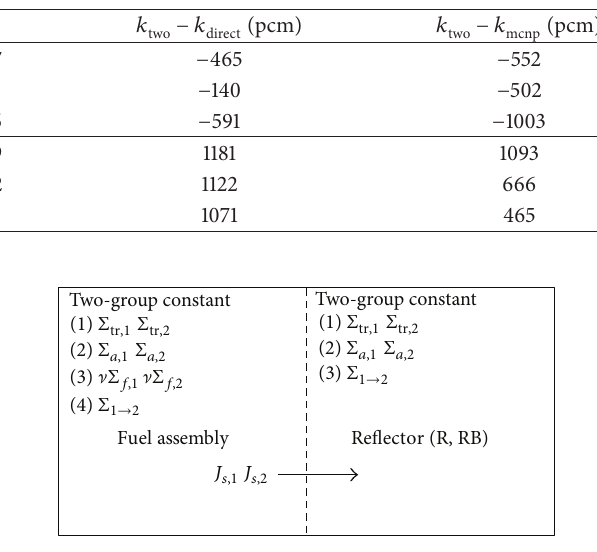
Figure 8: The reflector model (FA-R or RB) for two-group diffusion equation, where Σ tr ,𝑔 is the transport cross section and 𝐽 𝑠,𝑔 is the interface net current; 𝑔 is the energy group